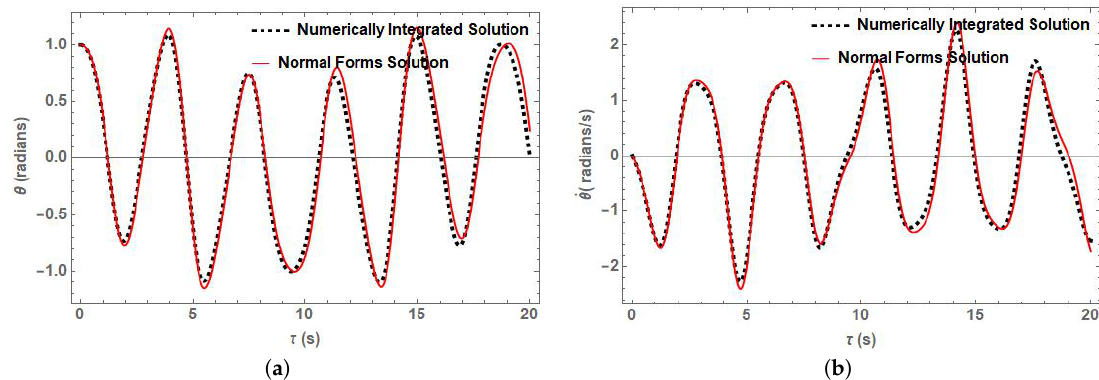
Figure 6. Comparison of temporal variations of the reduced SSF system states ( a ) Roll angle variation with respect to time, ( b ) Roll angular rate variation with respect to time.